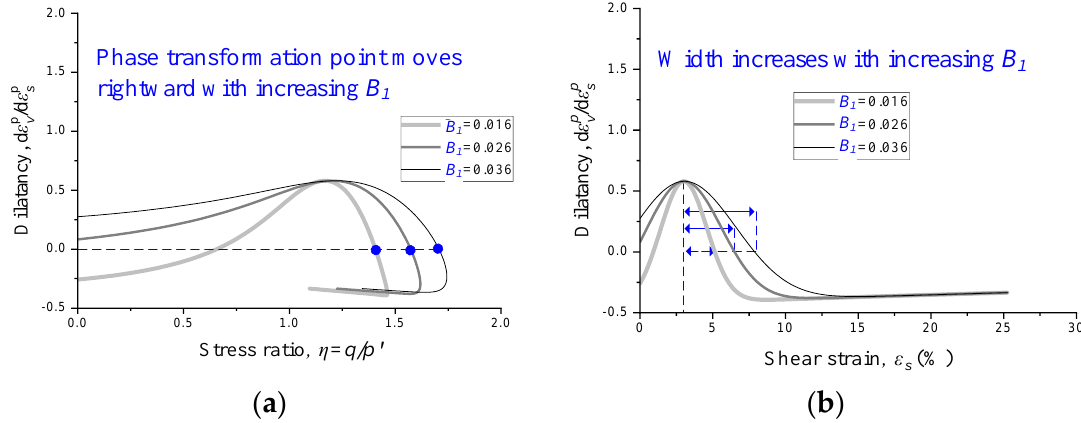
Figure 4. Effect of B 1 on dilatancy: ( a ) flow rule defined on the plane of dilatancy versus shear strain, and ( b ) flow rule defined on the stres − dilatancy plane.